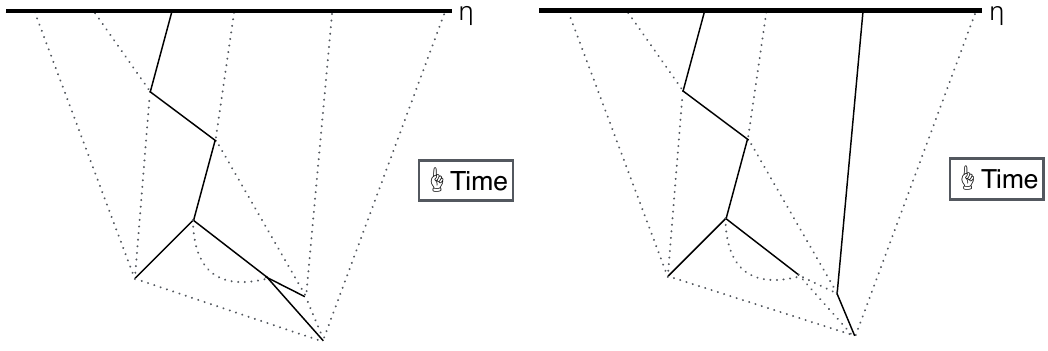
(cid:10) (cid:11) Figure 3 . Examples diagrams of (cid:30) 6 evaluated at correlation time (cid:17) in (cid:21)(cid:30) 4 theory at ( (cid:21) 7 ). For O visual clarity we have separated out the six correlation points, though we generally take them to be spatially coincident, as well. Left: illustration of the statement that if the subdiagram containing all V retarded propagators is a connected tree that only touches the correlation point once, then it necessarily touches all V vertices. Solid lines are G R and dashed lines are G + propagators. Right: an example of the general situation with multiple disconnected subgraphs. By the same argument, each one is a tree that touches one and only one external correlation point and contains a number of propagators equal to the number of vertices in the